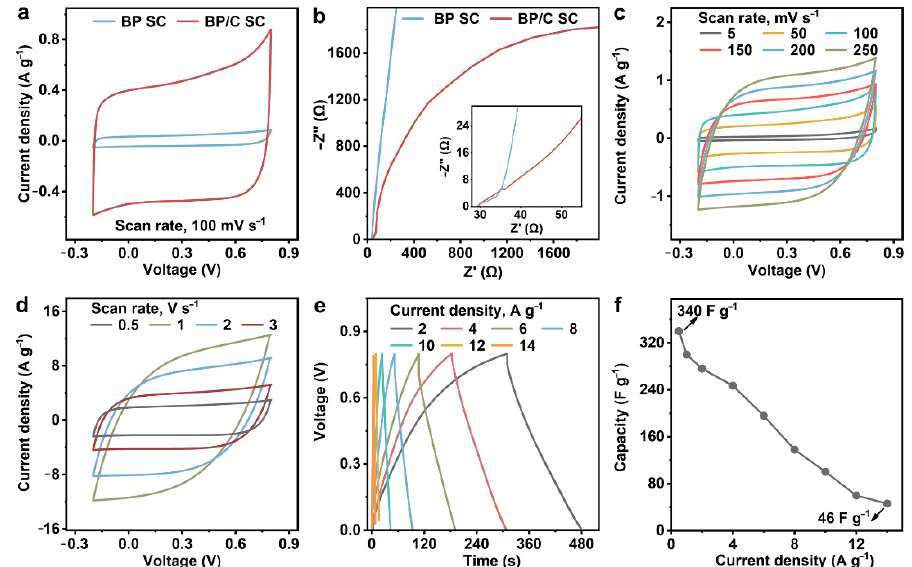
Figure 3. Electrochemical properties of BP/C SC. ( a ) Cyclic voltammetry curves of BP/C SC and BP SC at 100 mV s − 1 . ( b ) Electrochemical impedance spectra of BP/C SC and BP SC with an insert of mid–low-frequency region spectra. ( c , d ) Cyclic voltammetry curves of BP/C SC at ( c ) 5–250 mV s − 1 and ( d ) 0.5–3 V s − 1 . ( e ) Galvanostatic charge–discharge curves of BP/C SC under different current densities. ( f ) Capacity of BP/C SC at 0.5–14 A g − 1 .